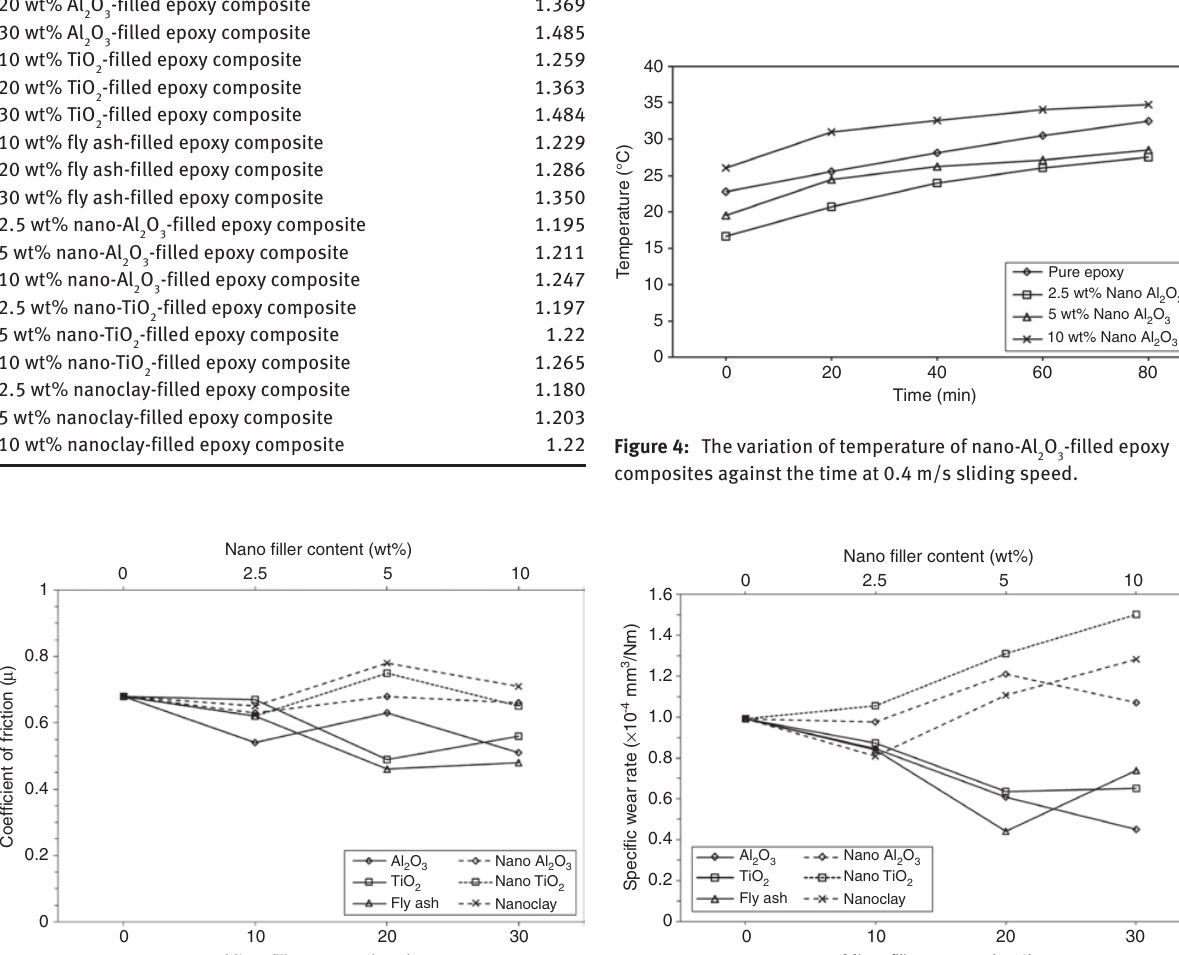
Figure 3: The variation of temperature of Al ites against the time at 0.4 m/s sliding speed.